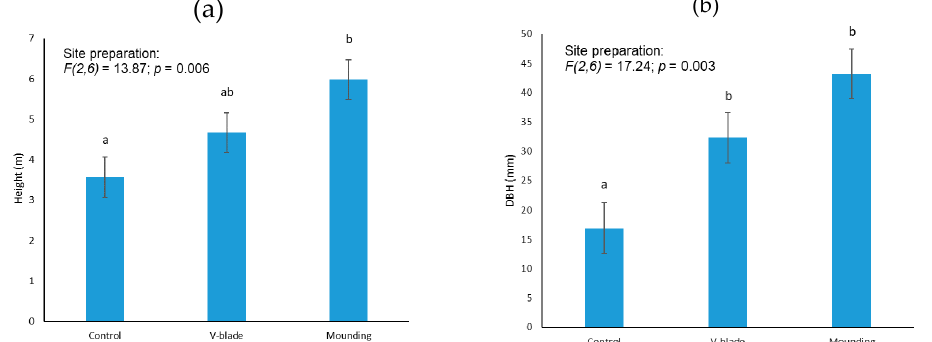
Figure 2. Effects of mechanical site preparation treatments on hybrid poplar sapling height ( a ) and diameter at breast height (DBH) ( b ) after four growing seasons, along with results from the linear mixed models (values in parentheses are the numerator and denominator degrees of freedom). p -value for the random block effect was < 0.001 for both variables. For a given variable, values with similar letters are not significantly different at α = 0.05 based on Tukey HSD pairwise comparisons. Data are presented as means ± standard error. Table 1. Synthesis of the linear mixed model results for hybrid poplar foliar nutrition and soil inorganic N, as measured four growing seasons after planting.